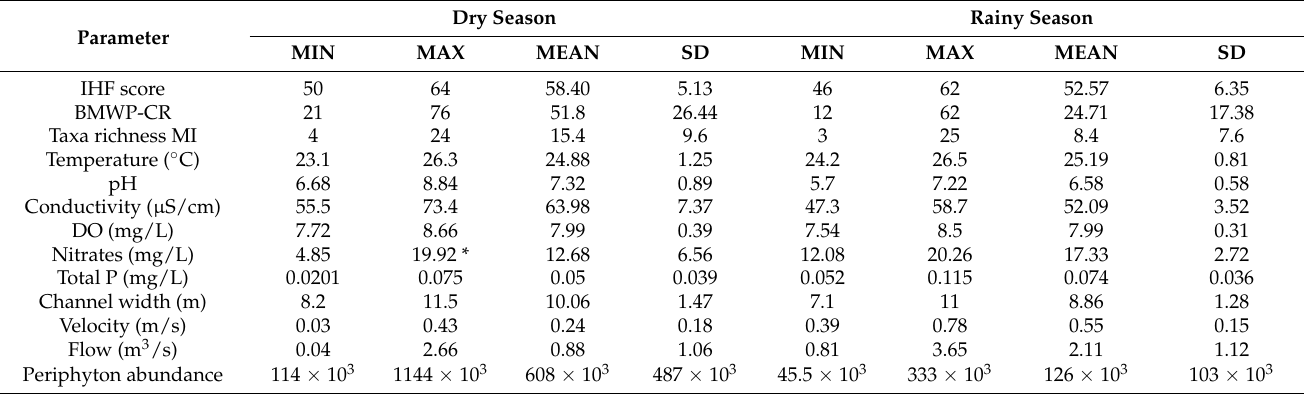
Table 5. Minimum, maximum, mean, and standard deviation of the variables measured or estimated in the 2018–2019 sampling period in the Peje stream. Information is presented separately for the dry and rainy